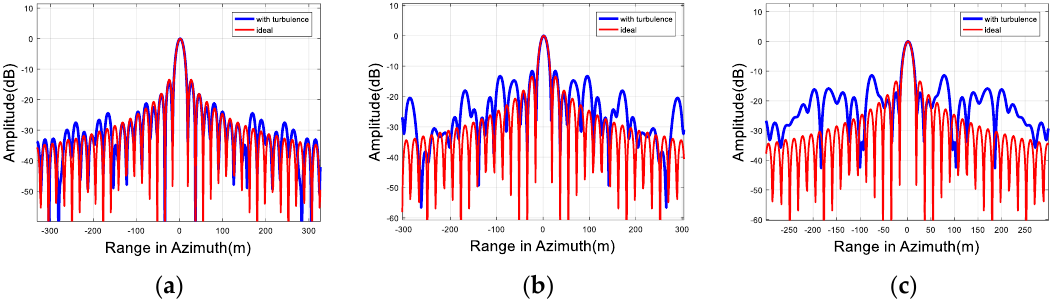
2 = 0.1 cm 2 ; ( b ) σ 2 n n